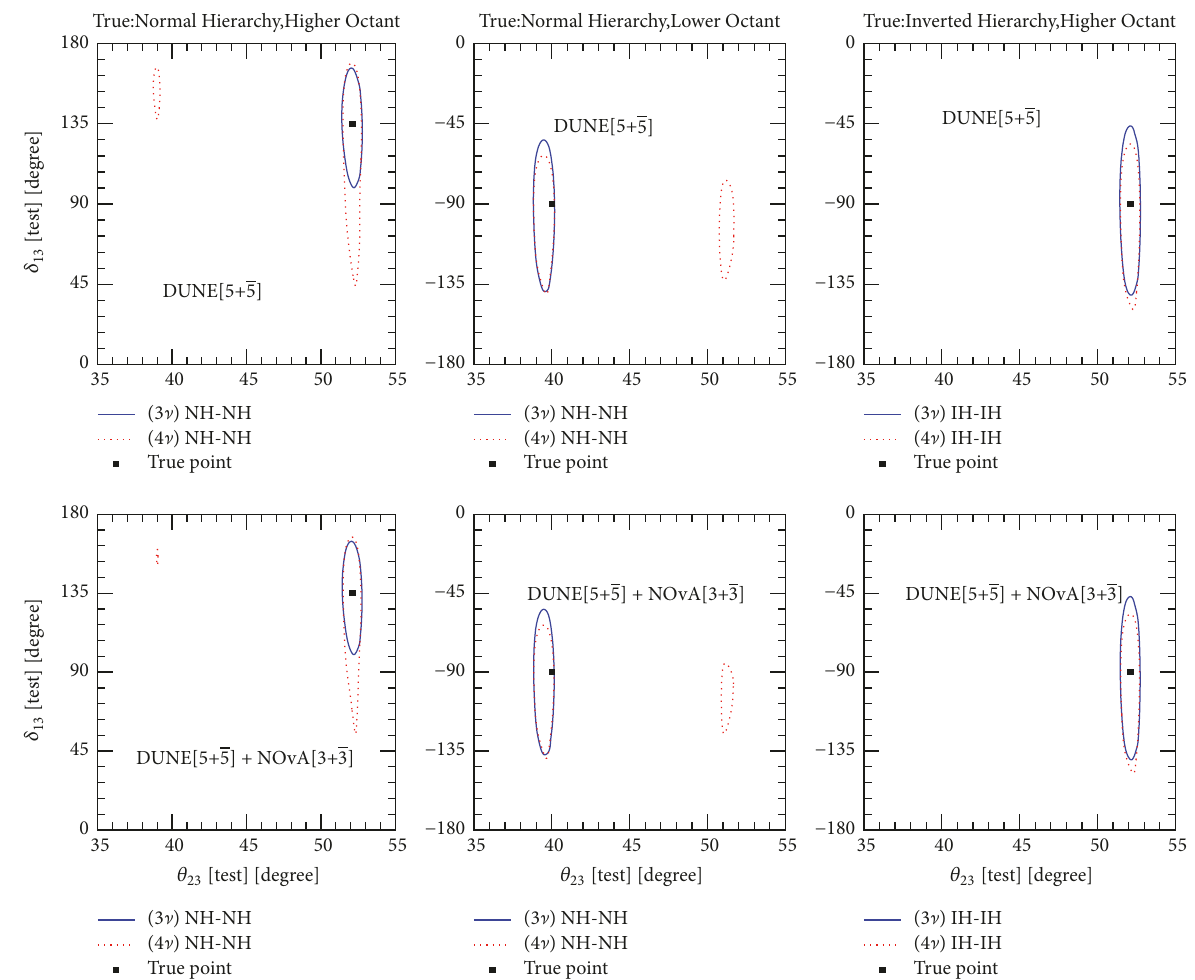
Figure 5: Contour plots of allowed regions in the test plane 𝜃 23 versus 𝛿 13 at 99% C.L with top and bottom rows for DUNE[ 5 + 5 ] and NO ] A[ 3 + 3 ] + DUNE[ 5 + 5 ],